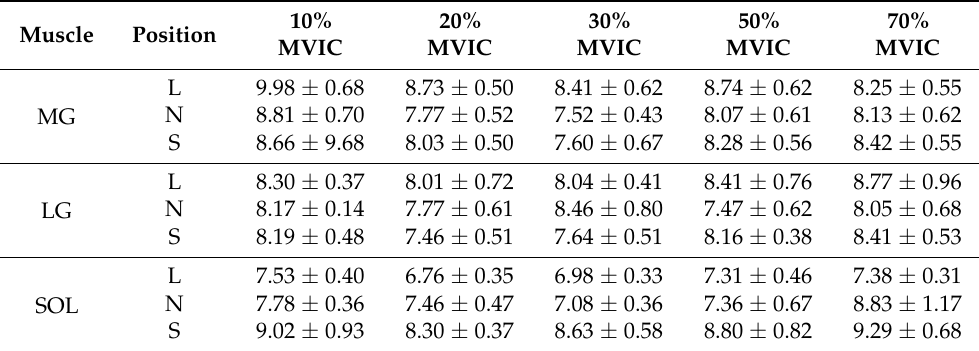
Table 2. Relative variability of MG, LG, and SOL (MG CoV , LG CoV ,and SOL CoV ) at different contraction intensities and ankle joint angles. L: Longer muscle length (87°); N: Neutral muscle length (100°); S: Shorter muscle length (116°). Data shows as Mean ± SEM. Unit: %. Muscle